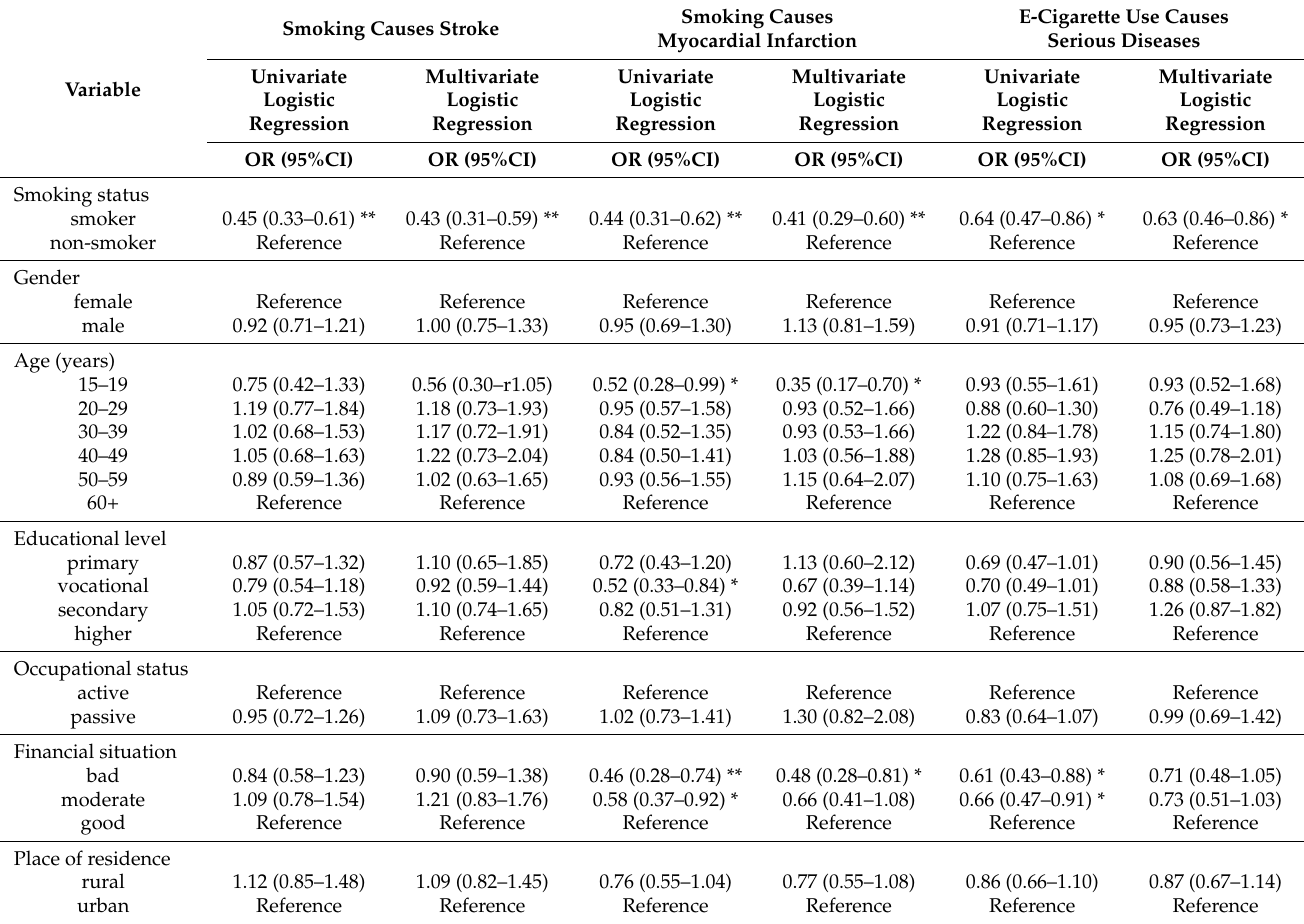
Table 3. Awareness of selected health effects of using tobacco and e-cigarettes by sociodemographic factors: Odds ratios (OR) and 95% confidence intervals (95%CI), n =